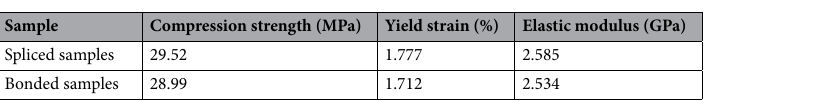
Table 2. Mean static parameters of bonded and spliced